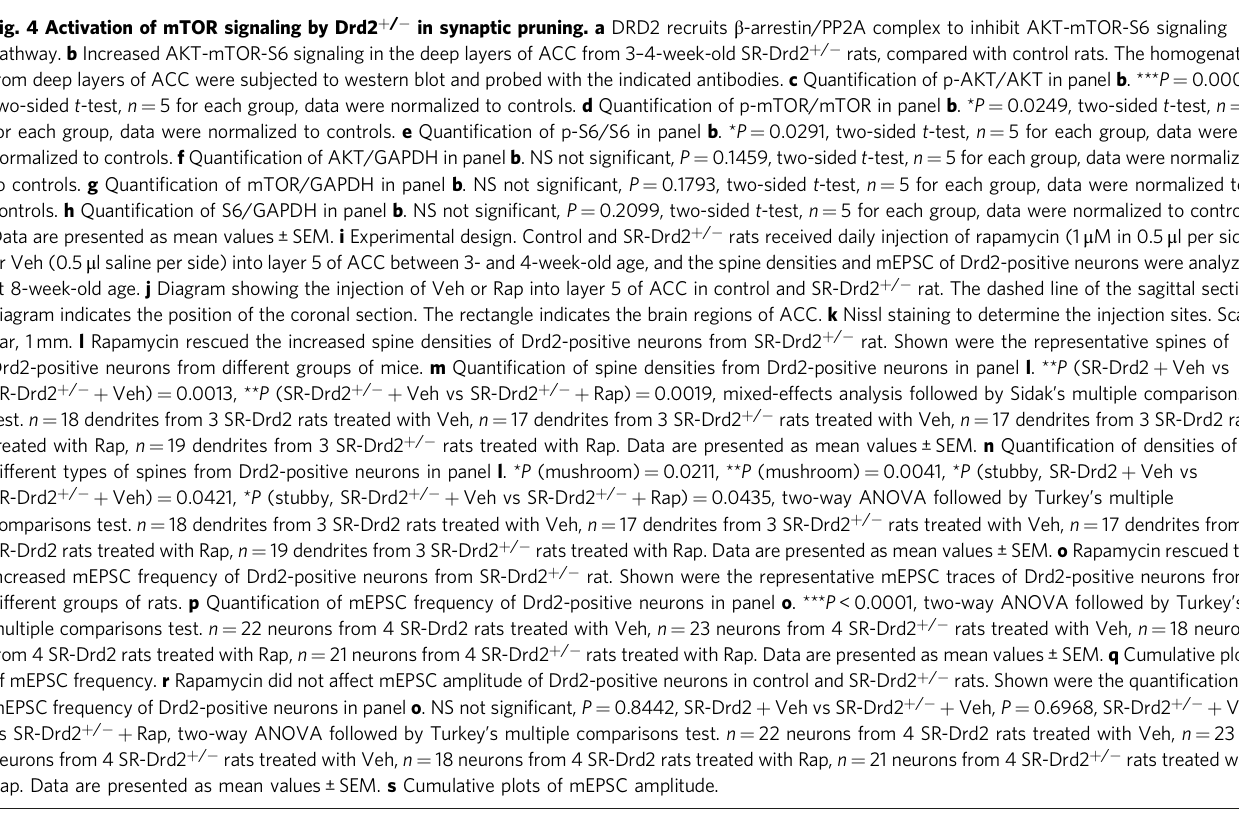
Fig. 4 Activation of mTOR signaling by Drd2 + / − in synaptic pruning. a DRD2 recruits β -arrestin/PP2A complex to inhibit AKT-mTOR-S6 signaling pathway. b Increased AKT-mTOR-S6 signaling in the deep layers of ACC from 3 – 4-week-old SR-Drd2 + / − rats, compared with control rats. The